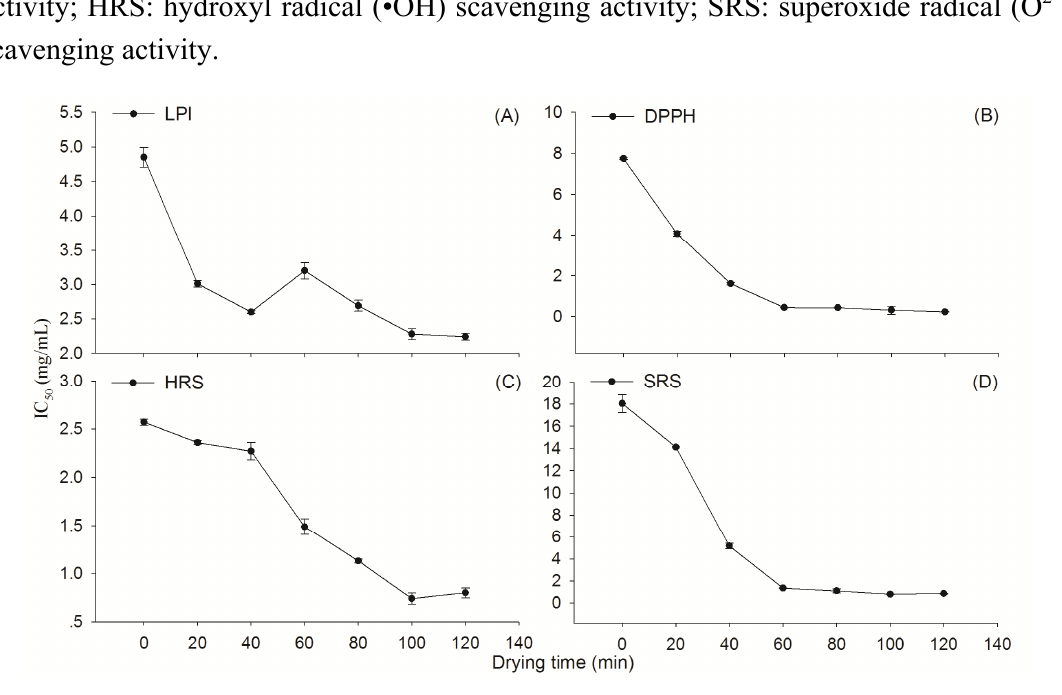
Figure 7. Canonical correlation analysis between contents of four major salvianolic acids and IC of four antioxidant activities in Danshen samples dried at 130 °C. U: the raw 50 variables of contents; V: the raw variables of IC . Numbers on the black, red, green or 50 purple are coefficient between variables. See Figures 1 and 6 for abbreviations of analytes and antioxidant activities,